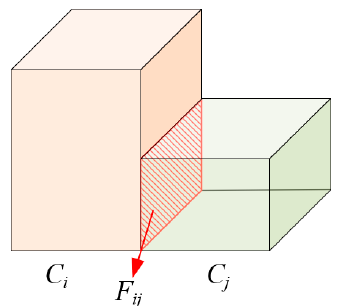
Figure 6. 2D and 1D topological relations between the 3D cells. ( a ) 2D topological relations between 3D cells are derived from the interfaces between cells and represented as 3D facets; ( b ) 1D topological relations between 3D cells are derived from the intersecting lines and represented as 3D edges.